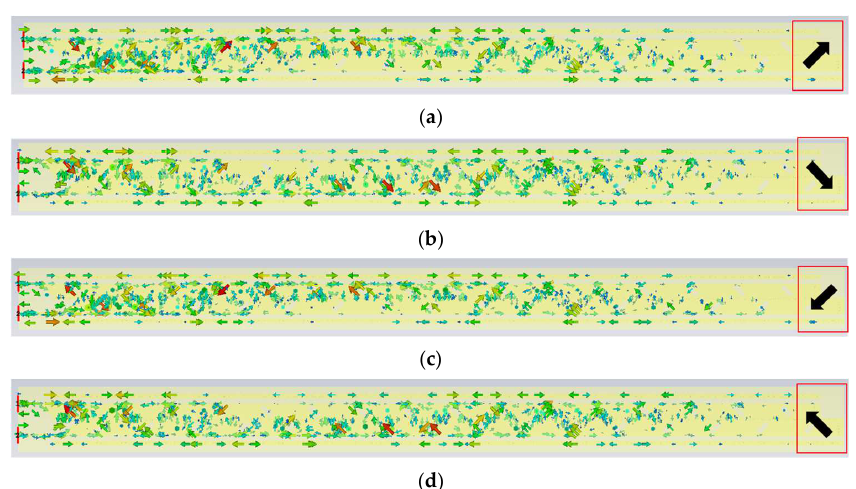
Figure 4. Configuration of the proposed HMSIW slot antenna (unit: mm).